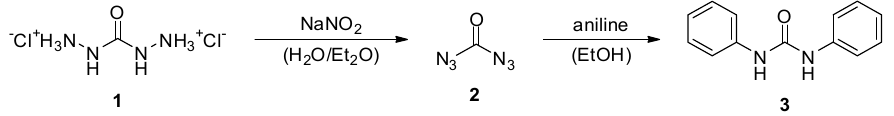
Scheme 1. Synthesis of carbonyl diazide ( 2 ) from carbonyl dihydrazide dihydrochloride ( 1 ) and transformation to diphenylurea ( 3 ).